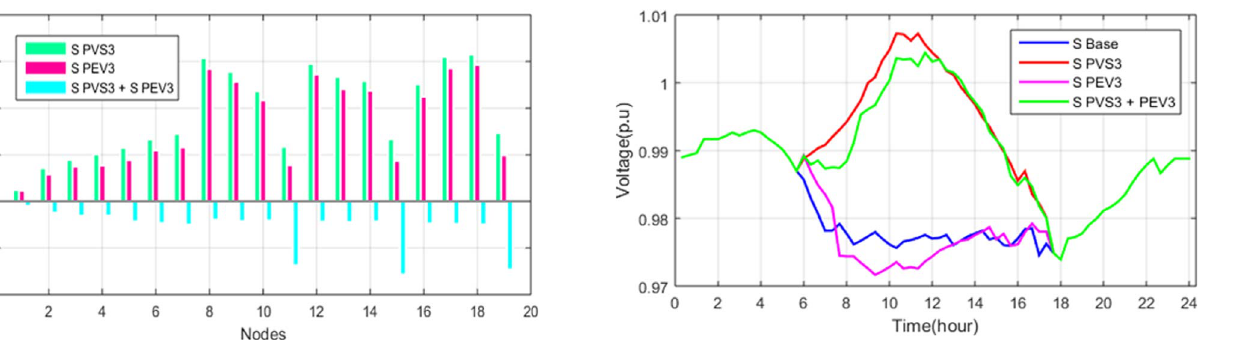
Figure 10. Analysis of system voltage differences in maximum level during summer.